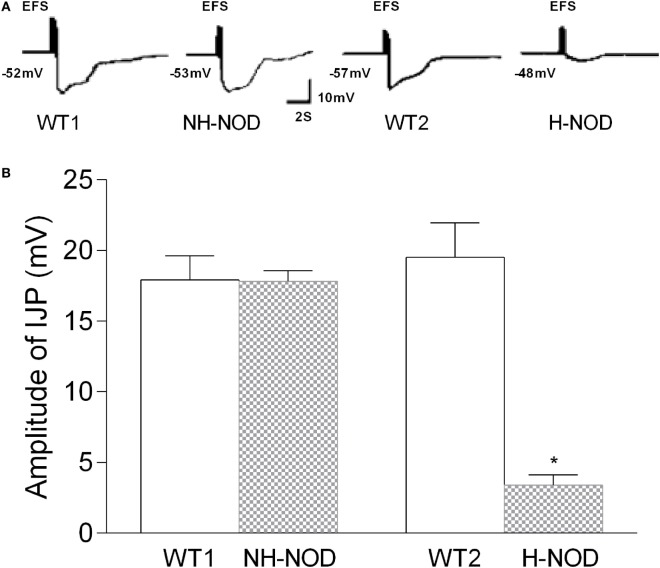
Compound IJP in wild-type (WT) controls, non-hyperglycemic NOD (NH-NOD), and hyperglycemic NOD (H-NOD). Panel (A) shows actual examples and panel (B) shows cumulative data on the amplitudes of the compound IJP. Note that in WT controls, the compound IJP consist of overlapping fast and slow IJPs. The amplitude of the compound IJP is due to the fast IJP [peaking at around 1 s after the onset of electric field stimulus (EFS)]. In NH-NOD mice amplitude of the compound IJP was not affected. However, but in H-NOD the compound IJP was markedly suppressed, and that peaked at around 4 s after the onset of the EFS, suggesting that fast IJP may be obliterated the slow IJP suppressed. Values are mean ± SD. *P < 0.001.